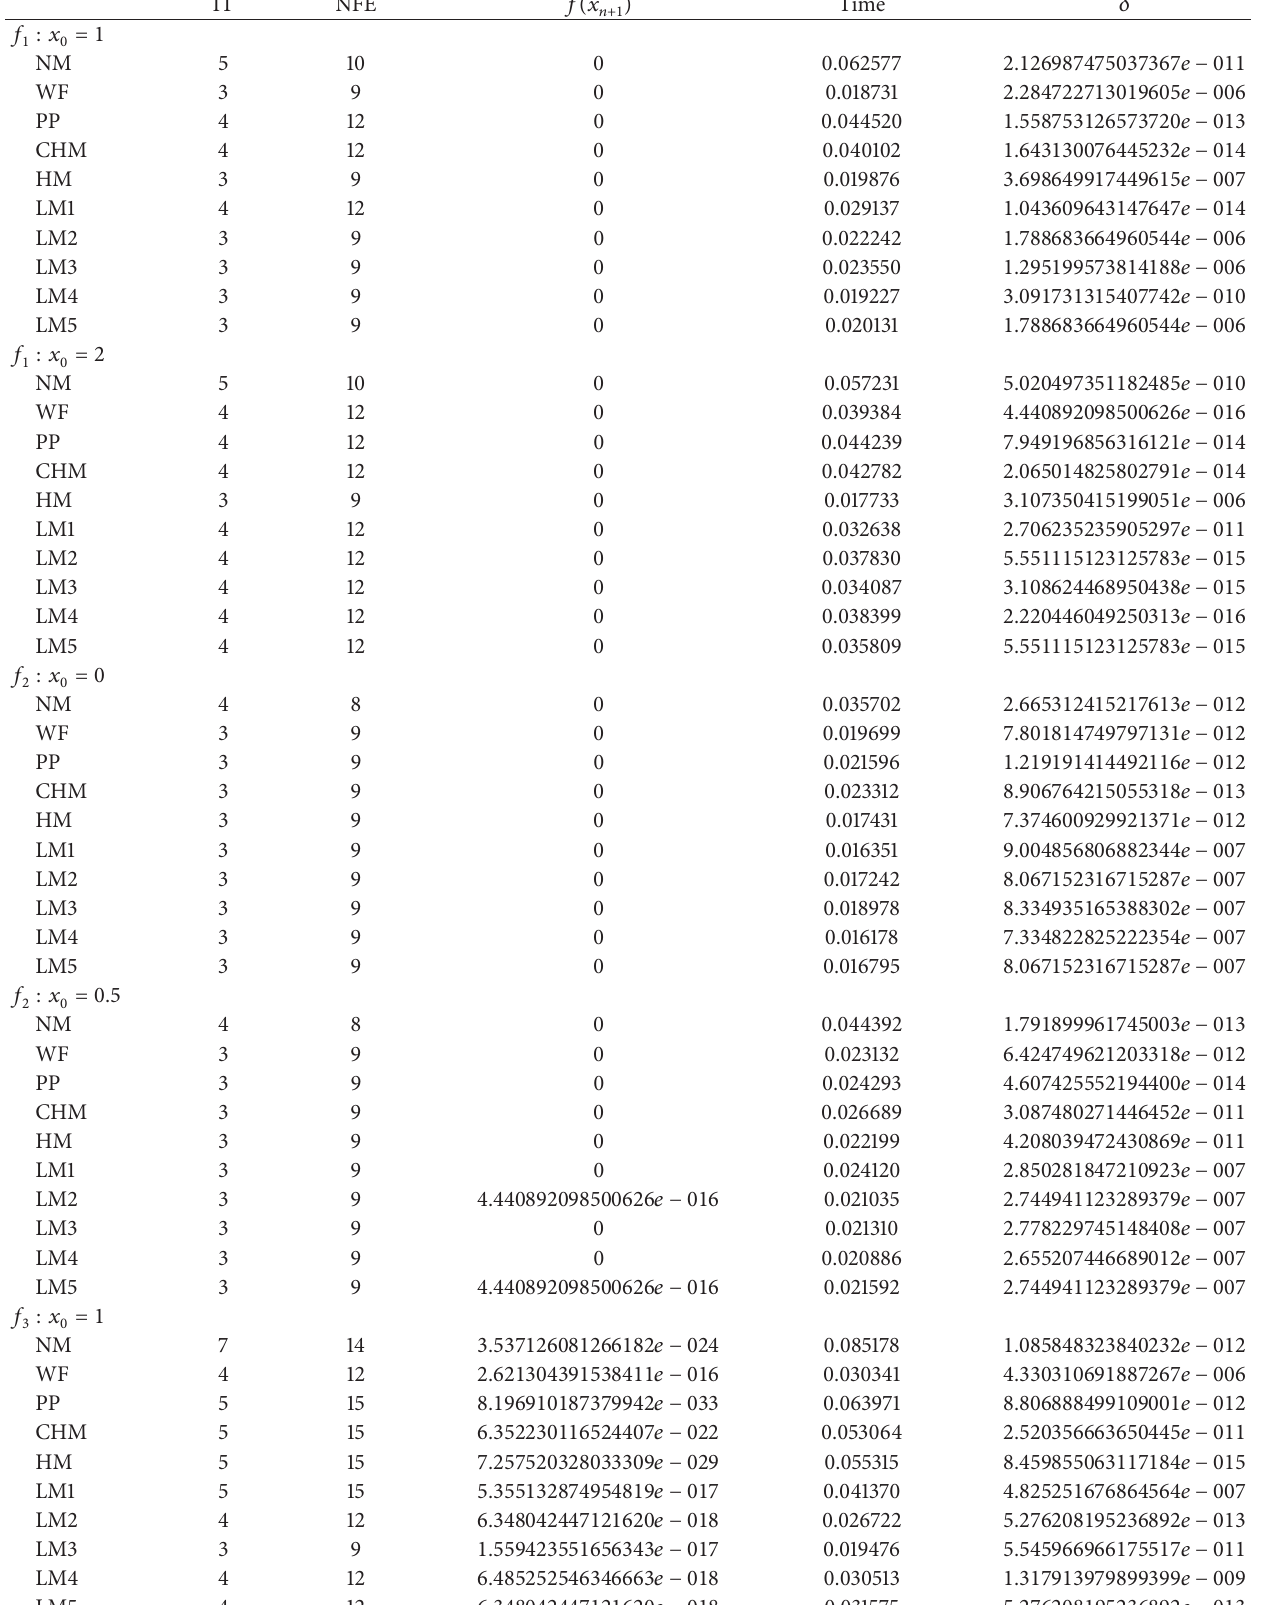
Table 1: Comparison of various third-order methods and Newton’s